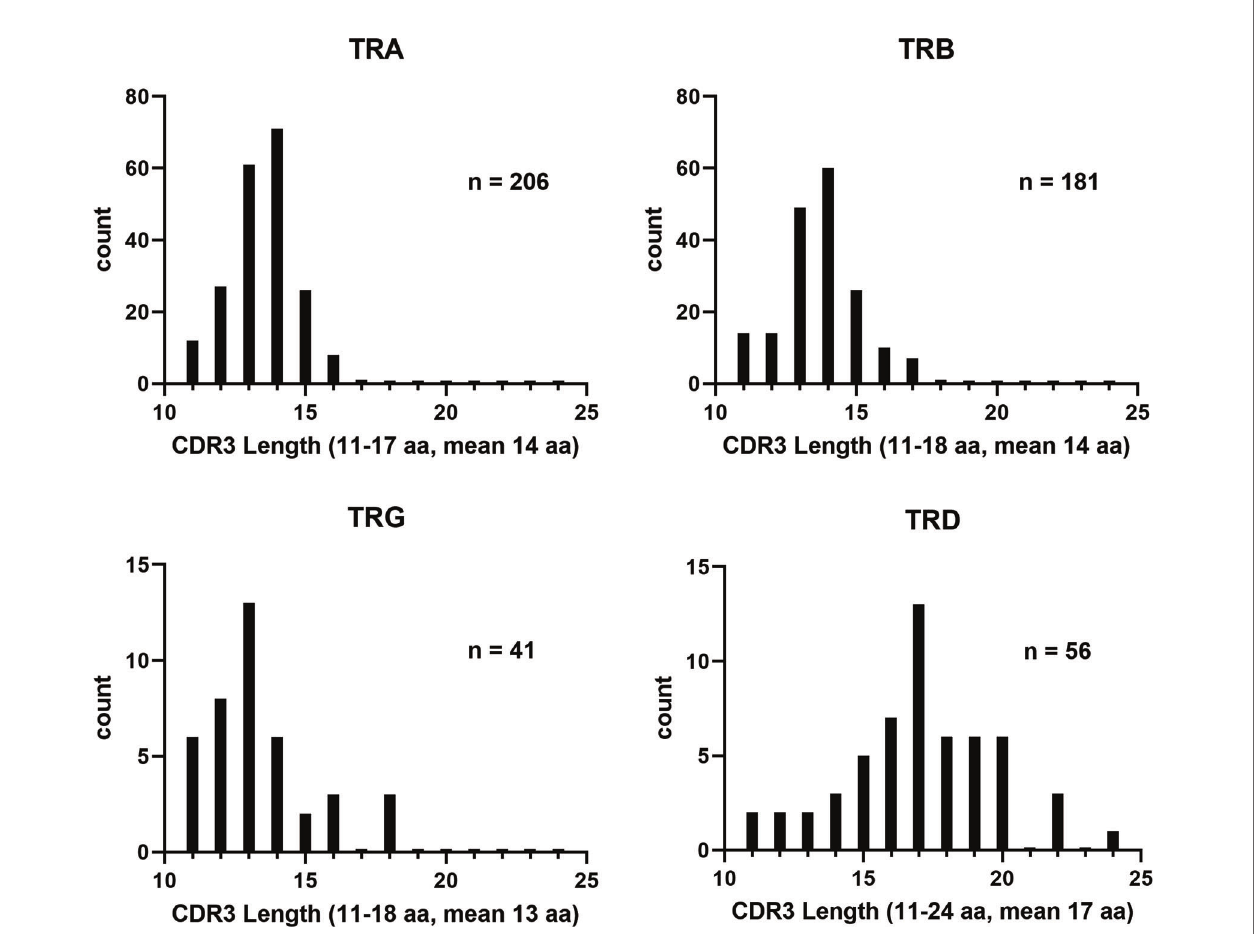
FIGURE 8 | Distribution of cat fi sh TR CDR3 lengths. Lengths of the CDR3 regions obtained from the clonotype analysis were graphed by isotype. The CDR3 regions were de fi ned as the region spanning codon CYS104 to PHE118. N values represent the number of clonotypes included for each